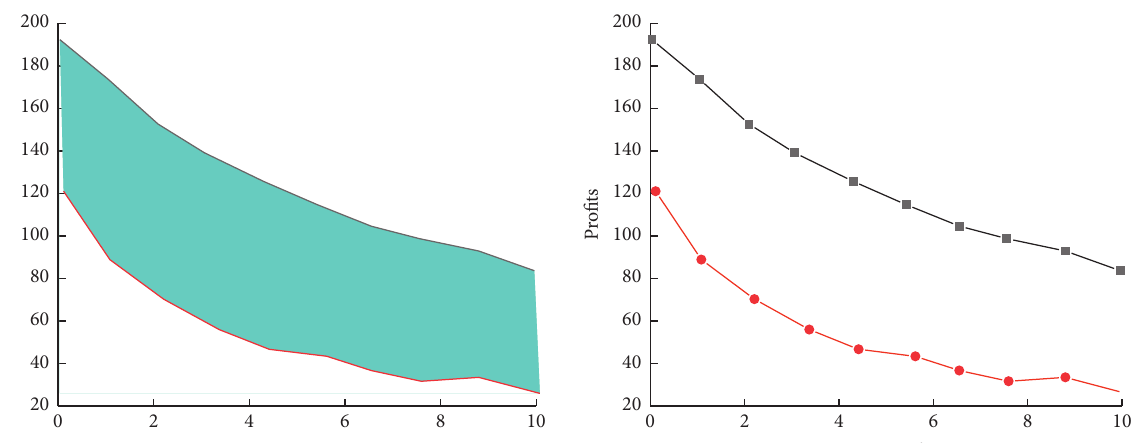
Figure 7: Influence of sensitivity coefficient on profit.